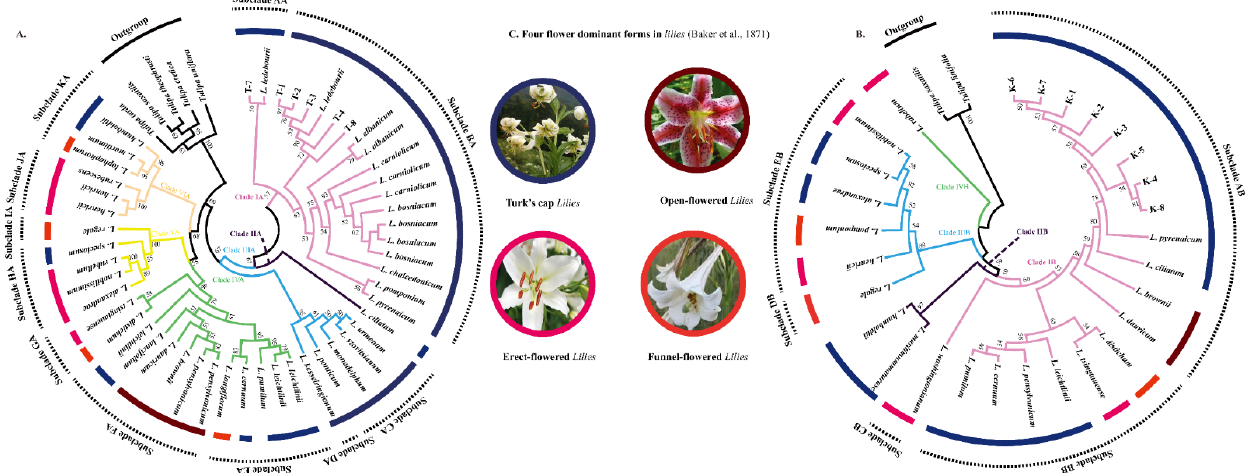
Figure 2. ( A ) Phylogenetic tree of Lilium based on ITS sequences (ITS1, 5.8 s, ITS2) with Maximum Likelihood method (model: Tumara3 parameter + Gamma distributed) and bootstrap 1000, ( B ) Phylogenetic tree of Lilium based on matK sequences with Maximum Likelihood method (model: Tumara3 parameter) and bootstrap 1000. (T and K legends are represented repeated sequences of ITS and matK regions from the Hyrcanian forest, respectively). ( C ) Four morphological flower types of the genus Lilium based on classification of Baker et al., 1871).